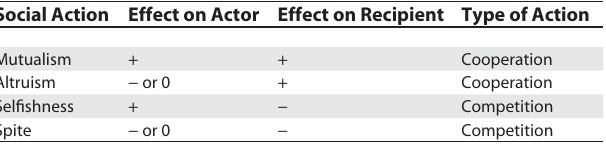
Table 1. The Four Types of Social Action Based on Their Effect on the Direct Fitness (Lifetime Personal Reproduction) of the Actor and Recipient Social Action Effect on Actor Effect on Recipient Type of Action